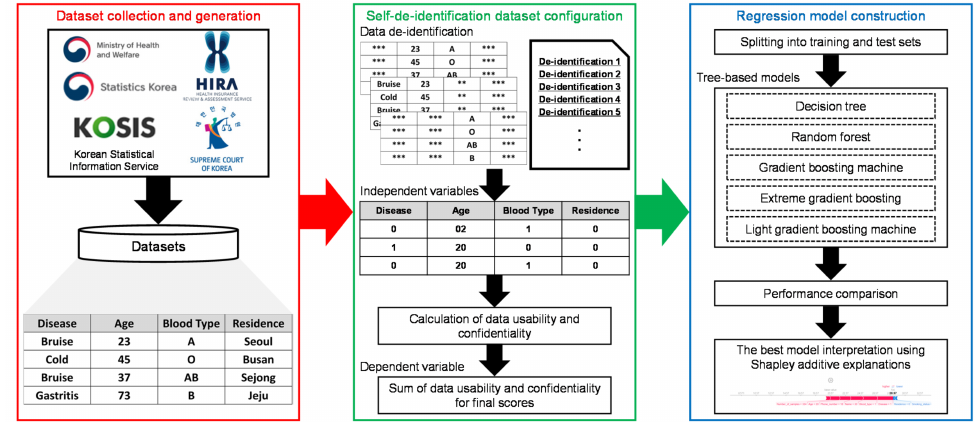
Figure 1. Overall architecture of the proposed approach. An asterisk (*) indicates a de-identified character from personal information.